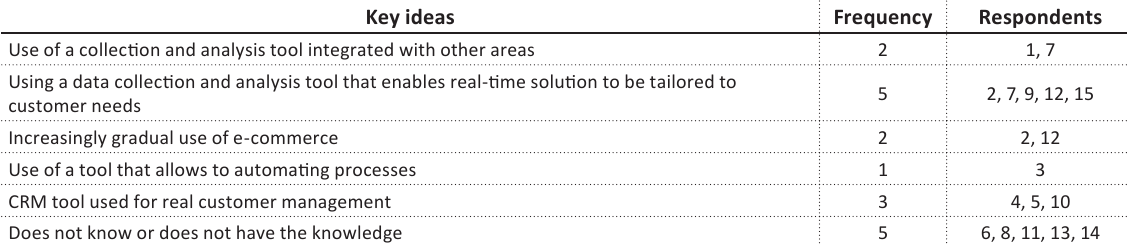
Table 6. Commercial perspective on the most beneficial tools in the future Key ideas